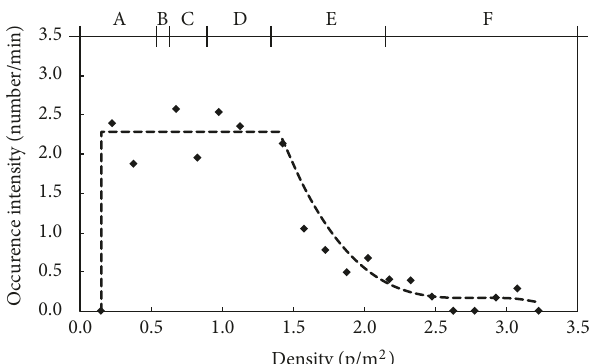
Figure 11: Occurrence intensity distribution of pedestrian evasive